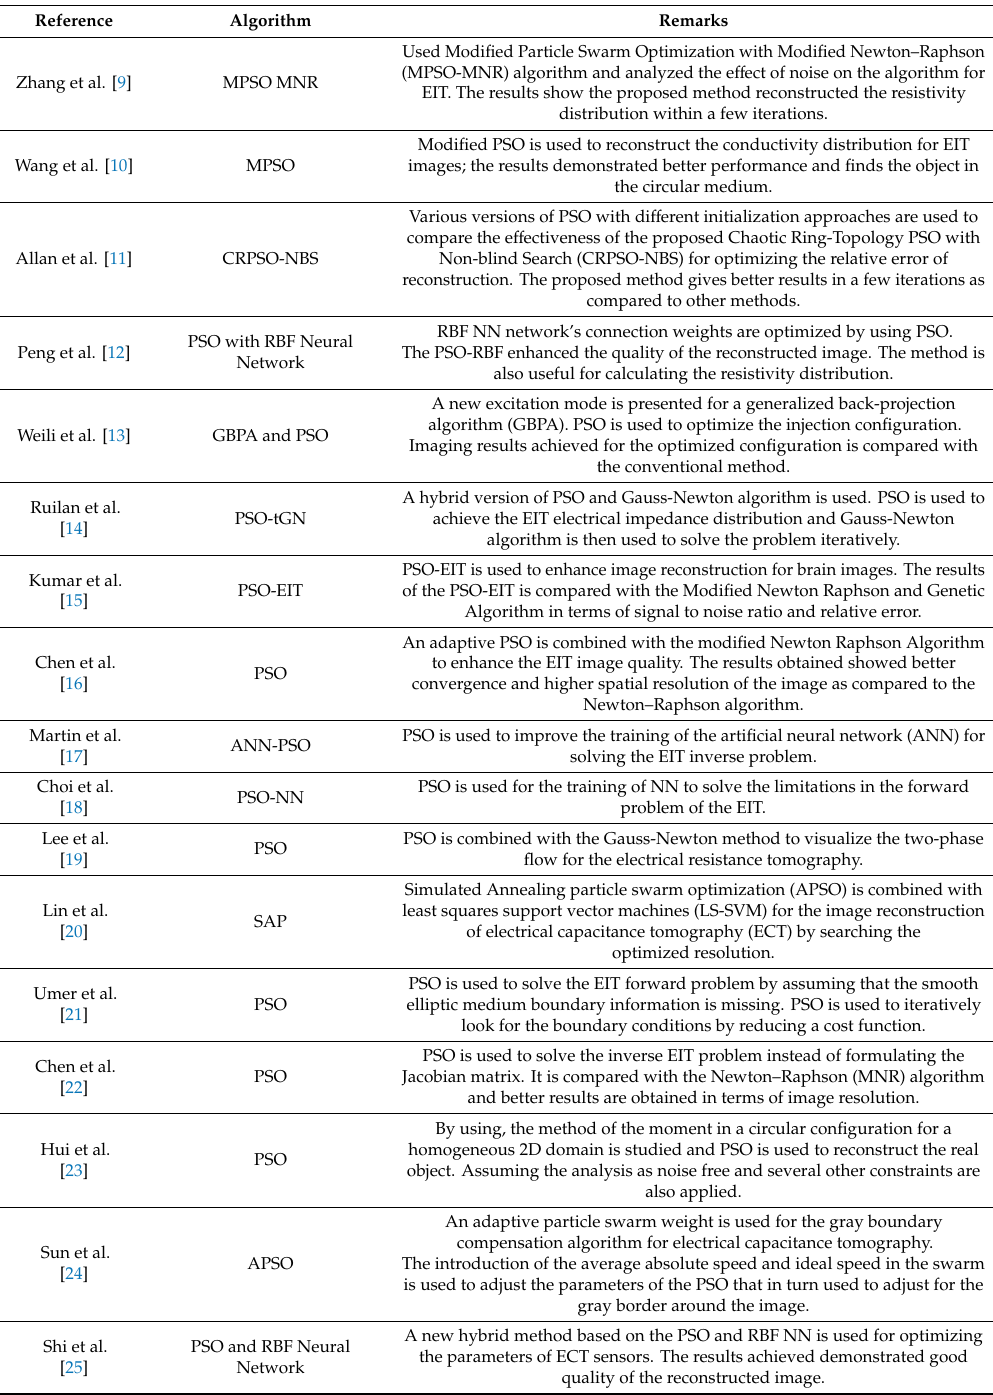
Table 1. Overview of papers using particle swarm optimization (PSO) approach for solving the Inverse